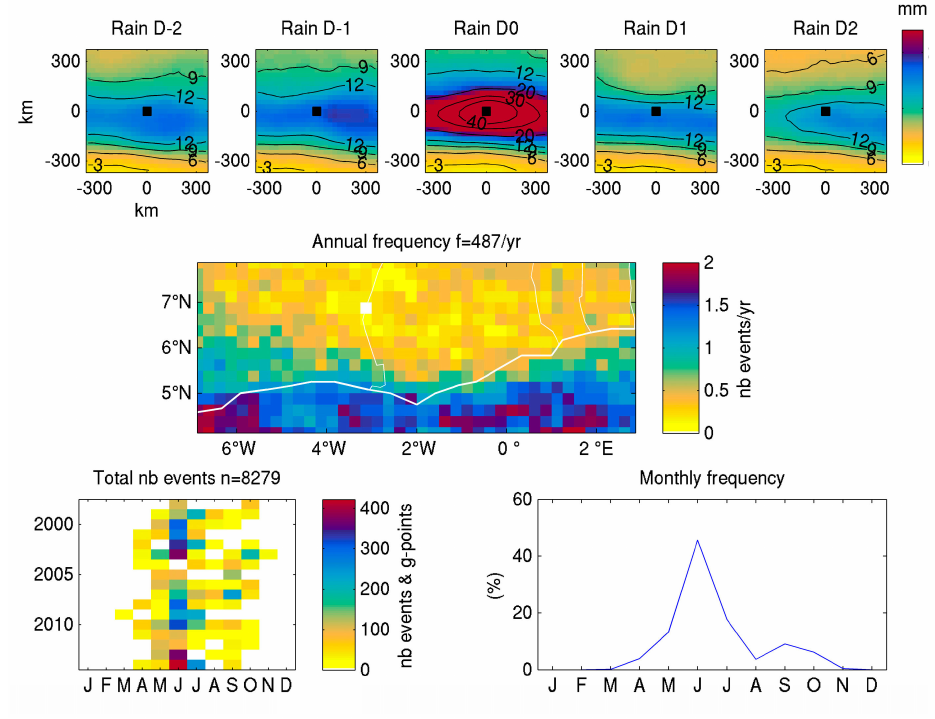
Figure 6. Same as Figure 5 but for cluster